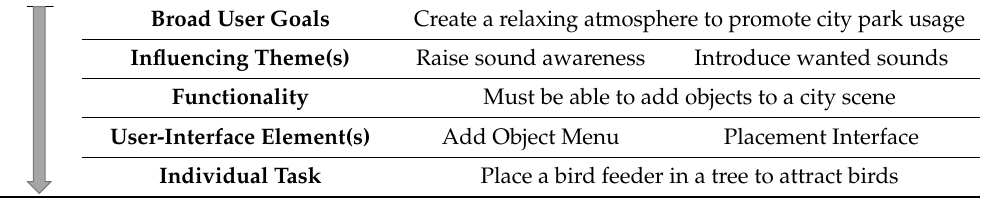
Table 2. Tracking user goals through themes, functionalities, and relevant user interface elements to produce an informed and testable task for users to complete.